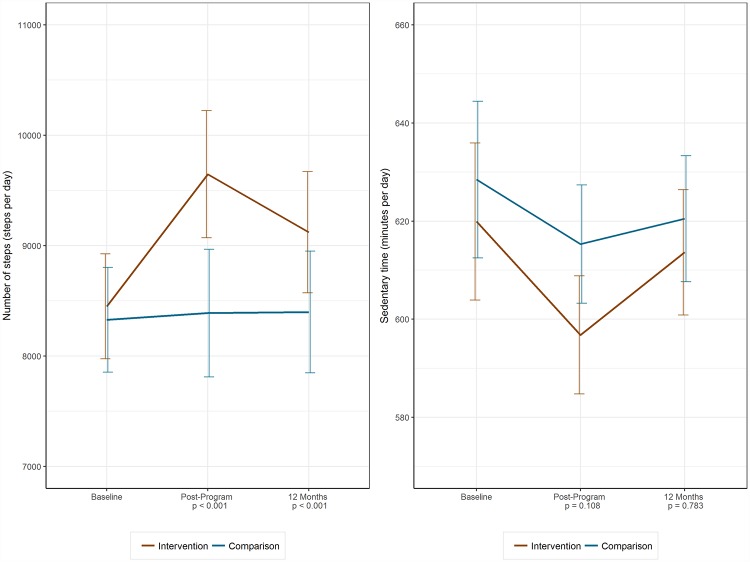
Primary outcomes (activPAL activity monitor).Model-predicted mean number of steps per day and daily sedentary time, based on repeated measures regression models.